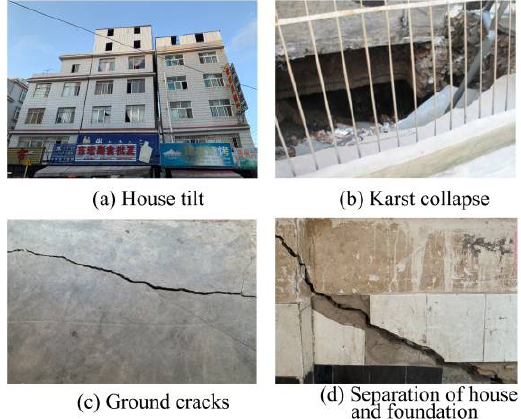
Figure 16. Field inspection map: ( a ) Tilt of house caused by land subsidence, ( b ) Due to excessive groundwater extraction, the surface subsides and deforms, eventually resulting in karst collapse, ( c ) Ground subsidence increases the activity of ground fissures and eventually leads to the formation of ground fissures, ( d ) Land subsidence will cause damage to buildings, causing building foundations to sink and houses to